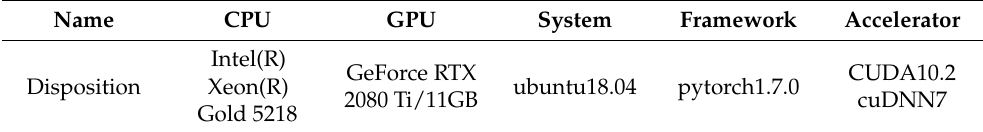
Figure 4. Schematic diagram of the comparison of PANet and BiFPN network structures. ( a ) PANet network structure; ( b ) BiFPN network structure (the convolution method in the Model E network structure is subject to the configuration in Table 2). Table 2. Laboratory environmental conditions established by the Model E